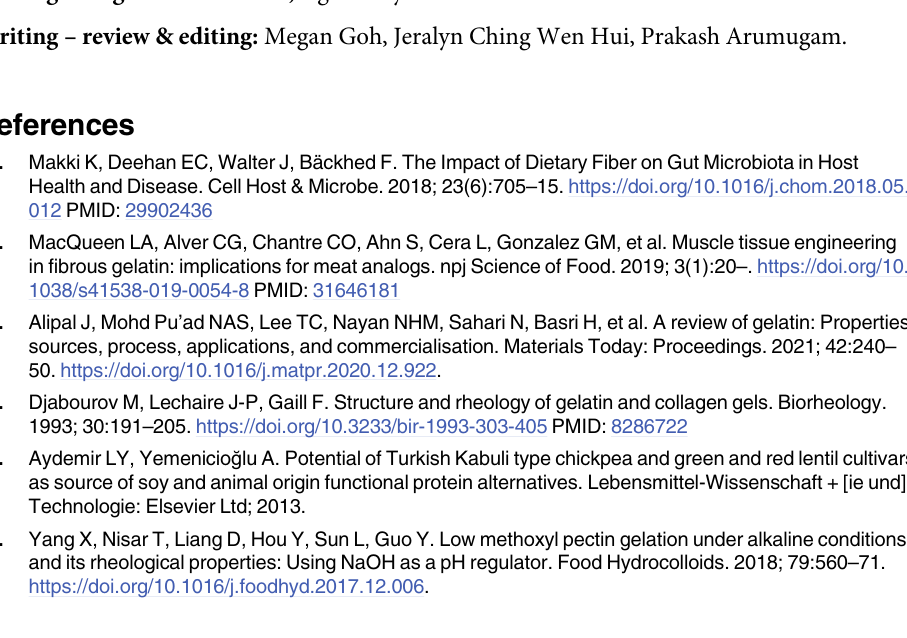
(TIF) S5 Fig. Low acyl gellan gum gels form stronger gels at pH 3.5 compared to pH 7.0. Data from two additional replicates for gelation results of low acyl gellan gum gels at pH3.5 are pre- sented in (A)–(C) and (D)–(F) respectively. (A) and (D) correspond to Thermocycler–Floating Sphere Assay; (B) and (E) correspond to Water bath–Floating Sphere Assay; (C) and (F) corre- spond to Water bath–Inversion Assay. (TIF) S6 Fig. Low acyl gellan gum gels form stronger gels at pH 3.5 compared to pH 7.0. Data from two additional replicates for gelation results of low acyl gellan gum gels at pH 7.0 are pre- sented in (A)–(C) and (D)–(F) respectively. (A) and (D) correspond to Thermocycler–Floating Sphere Assay; (B) and (E) correspond to Water bath–Floating Sphere Assay; (C) and (F) corre- spond to Water bath–Inversion Assay.